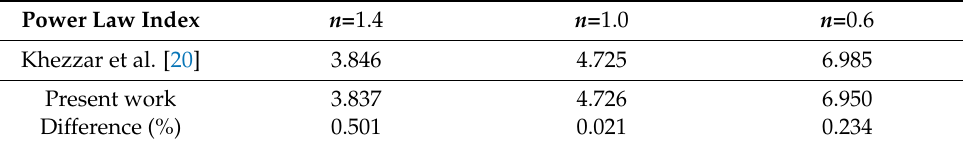
Table 1. Comparison between the average Nusselt number, Nu avg in a magnetic, in the work conducted Khezar et al. [20] and this study when Ra T = 10 5 and Pr = 100. Power Law Index n =